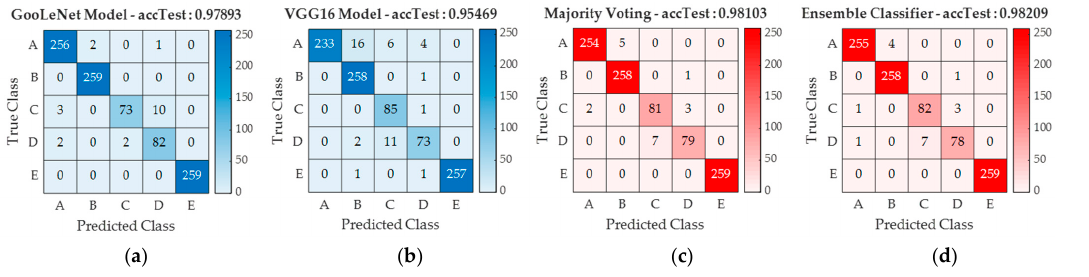
( d ) Figure 11. Confusion matrix: ( a ) best, ( b ) weakest, ( c ) voting, and ( d ) ensemble, of extraction dataset. Figure 12. Score activation map for analyzing network behavior using occlusion sensitivity.